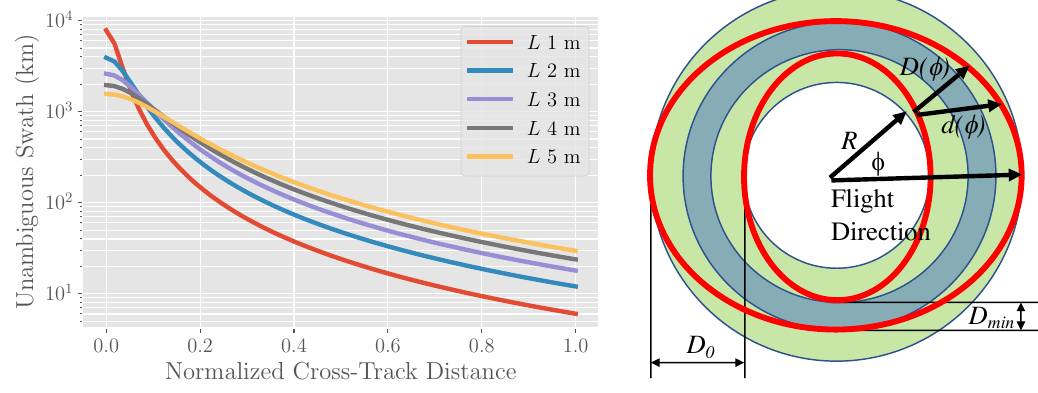
Figure 9. ( Left ) Width of the range-PRF unambiguous swath as a function of the normalized cross-track distance from the nadir path. A temporal correlation time of 1ms is assumed, and fixed antenna area. ( Right ) Cartoon illustrating the symbols used and showing how ambiguity and overlap requirements vary as a function of flight direction and scan angle. The blue annulus shows the region that has no range ambiguities using the broadside PRF. In green is the area that has no range ambiguities when looking along the flight path. The area enclosed by the red lines shows the area required to be covered to ensure along-track swath